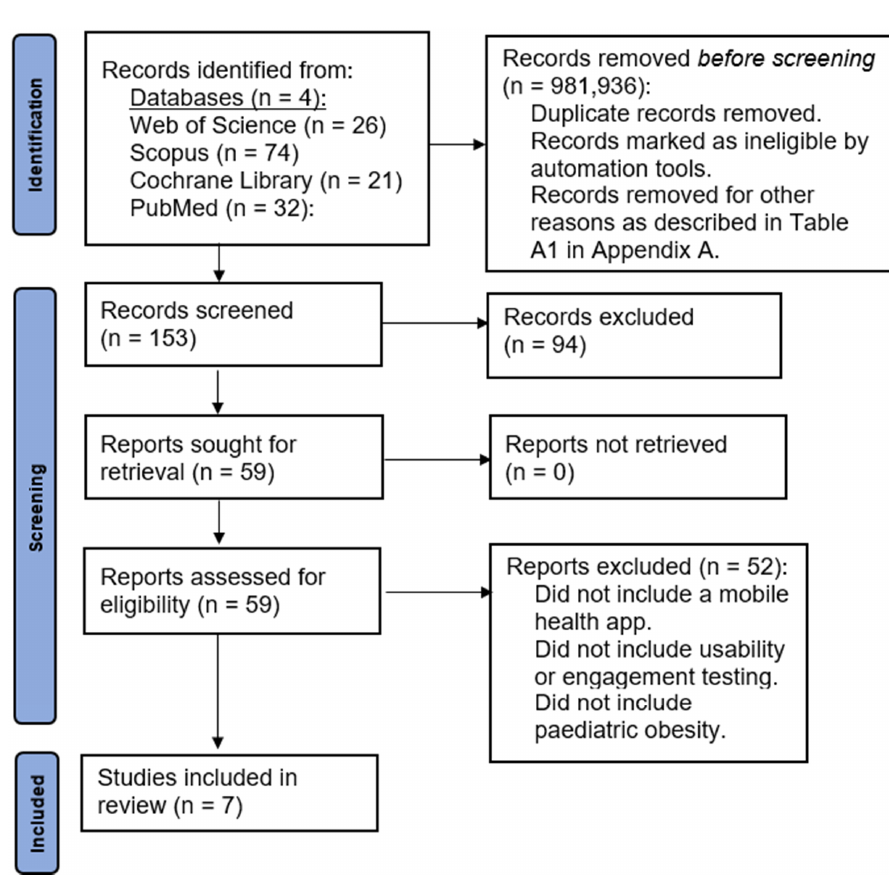
Figure A1. PRISMA flow chart outlining search results for literature review.